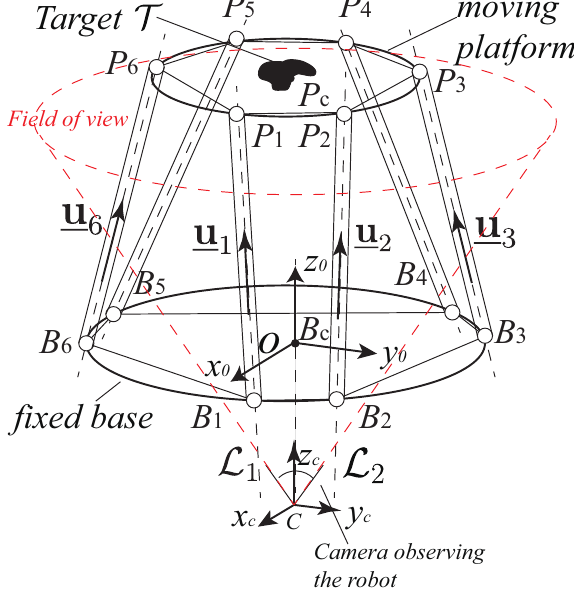
Figure 3. A camera observing the robot legs.